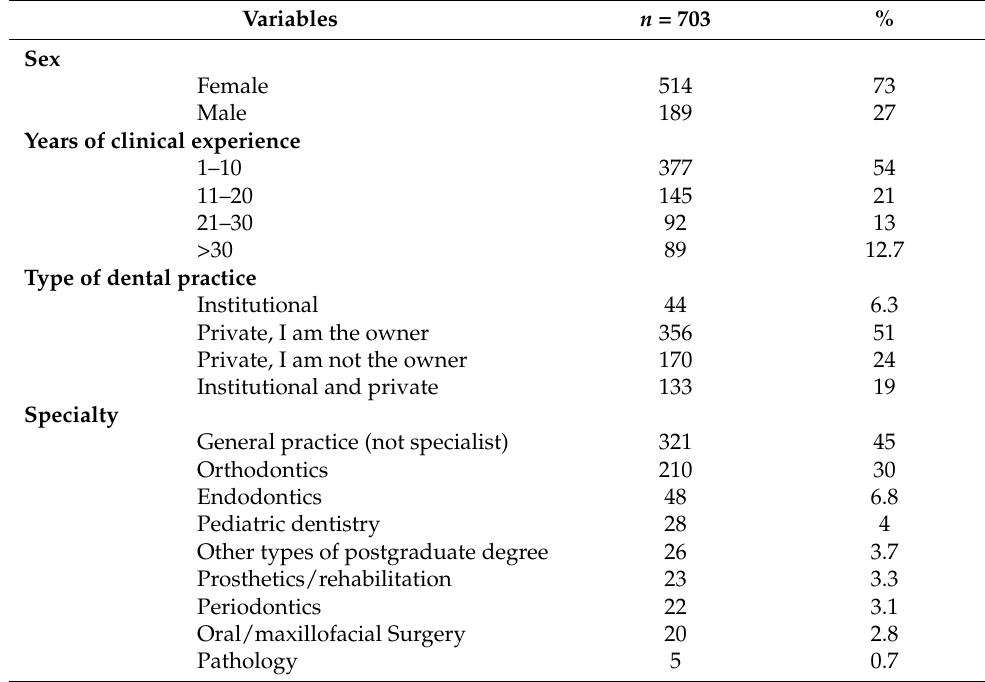
Table 1. Sociodemographic characteristics of the